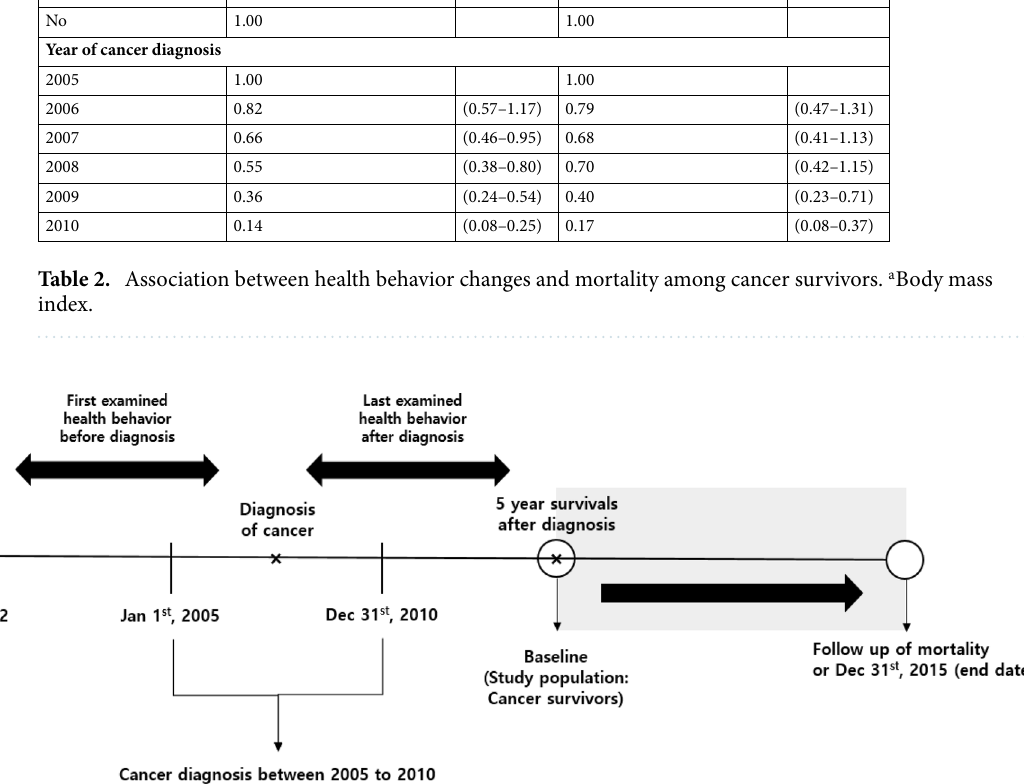
Figure 1. Timeline of the study on health behavior changes among cancer